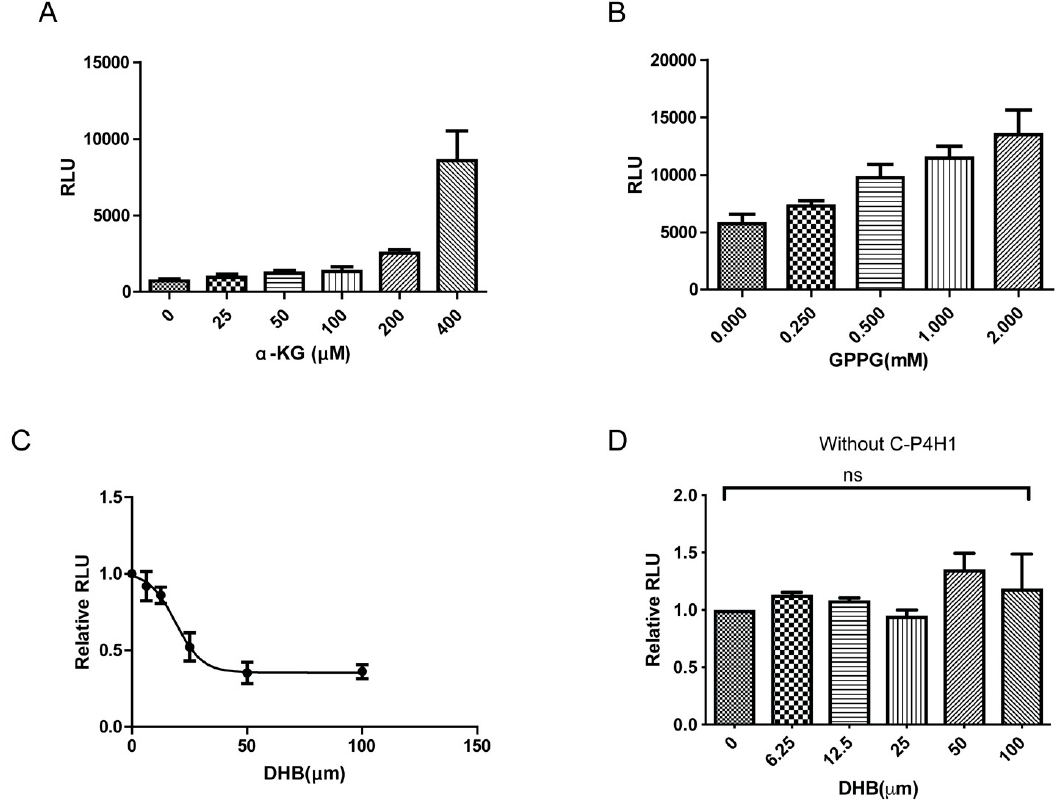
Figure 3. Evaluation of the Succinate-GloTM Hydroxylase assay for analyzing C-P4H1 activity. ( A ) Bar graph showing the C-P4H1 (200 nM) activity at different concentrations of 2-KG. n = 3. ( B ) Bar graph showing the C-P4H1 (200 nM) activity at different concentrations of substrate peptide GPPGOET. n = 3. ( C ) Curve measurement of the inhibitory activity of DHB in C-P4H1 (200 nM) reaction. All the ATP signals produced by the plate reader were normalized with control. n = 3. ( D ) DHB had little effect on the Succinate-GloTM Hydroxylase assay in the absence of C-P4H1. All the ATP signals produced by the plate reader were normalized with control, control value is 1. n = 3. ns means no significant statistic. The data displayed as means ± standard deviation (SD).